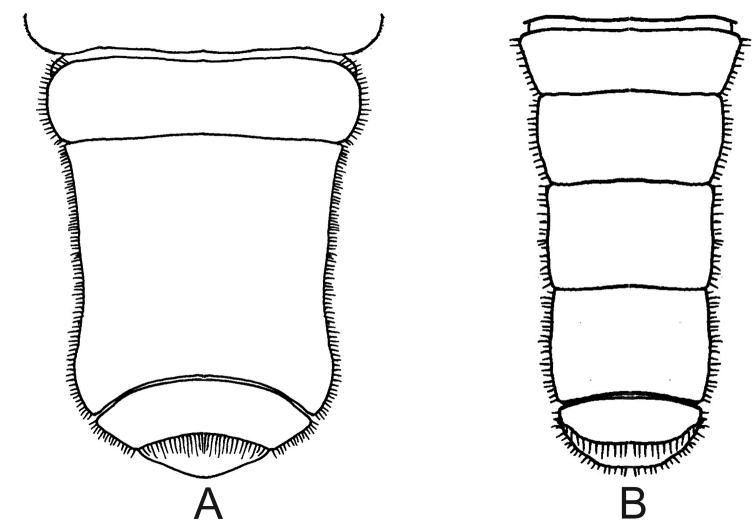
Abdomen of male, ventral view. ALeptuca
leptodactyla, middle somites fused BLeptuca
cumulanta, all somites distinct.